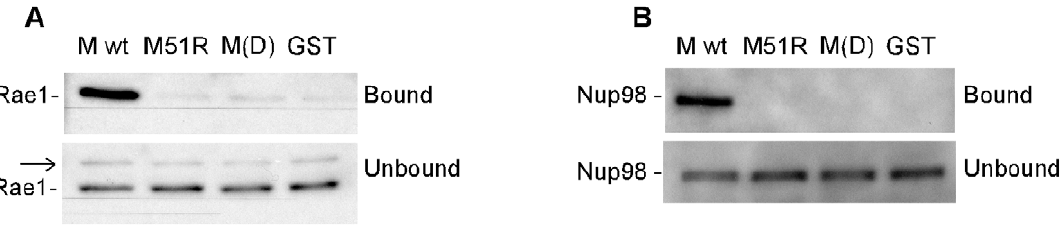
Figure 1. Specificity of interaction of M protein with Rae1 and Nup98. Recombinant wild type or mutant M protein GST fusion proteins or GST alone on glutathione beads were incubated for 1 hour with lysates from HEK 293 cells. Bound and unbound fractions were analyzed by immunoblotting and probed for Rae1 ( A ) or Nup98 ( B ). Arrow in unbound fraction in ( A ) indicates unrelated protein cross-reactive with Rae1 antibody (see Figure